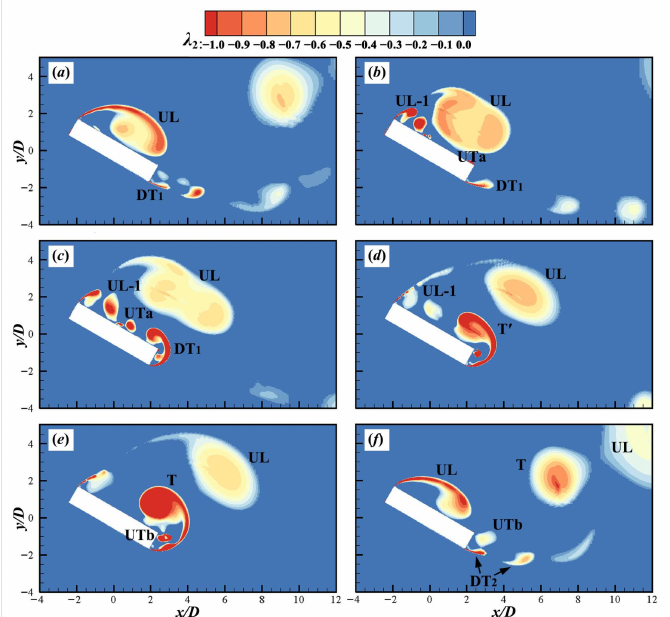
Figure 27. Vortex evolution within a vortex shedding period at α = 30 ◦ . ( a ) tU ∞ /D = 822.2, ( b ) tU ∞ /D = 828.6, ( c ) tU ∞ /D = 833.4, ( d ) tU ∞ /D = 836.4, ( e ) tU ∞ /D = 838.0, ( f ) tU ∞ /D =